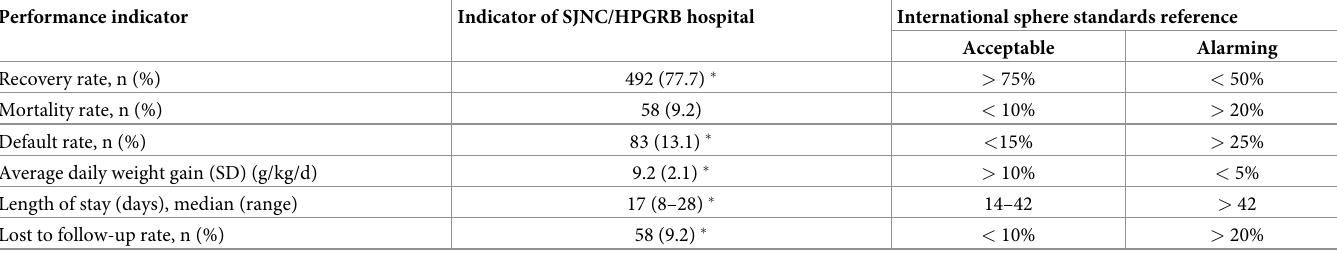
Fig 2. Main infectious diagnoses of severely malnourished children at SJNC/HPGRB hospital, June 2017–December 2018 (N = 633). https://doi.org/10.1371/journal.pone.0236022.g002 Table 2. Performance indicators of SJNC/HPGRB and sphere standard